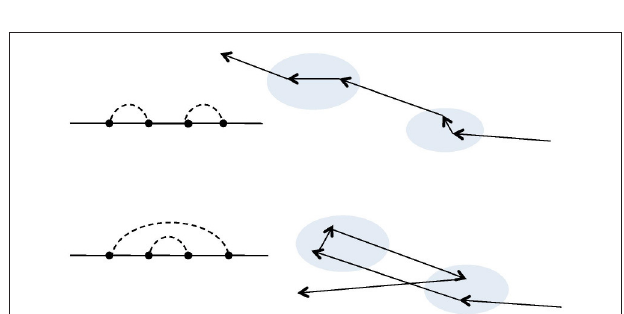
FIGURE 1 | (1) Feynman diagrams representation of the Dyson equation in the Born Approximation. (2) Feynman diagrams representation of the Dyson equation in the next order approximation of the perturbative series expansion, corresponding to truncation of the SCBA to the second step. It represents the starting point of the GBA.